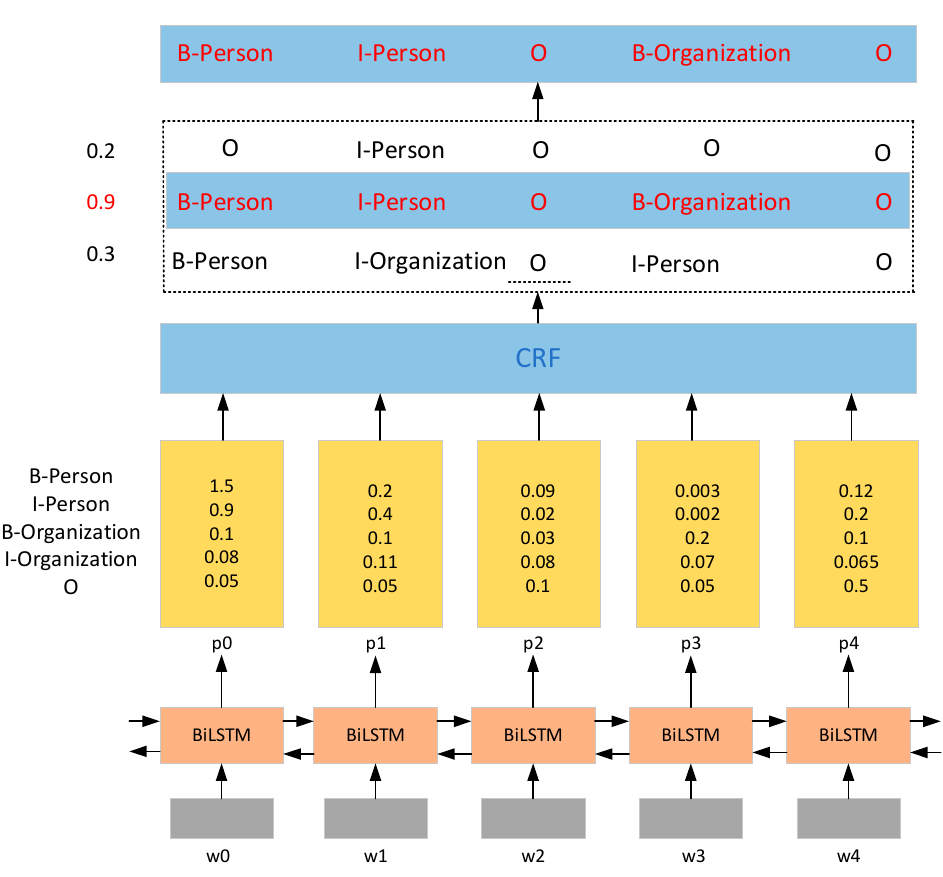
Figure 2. The structure of the BiLSTM-CRF model.